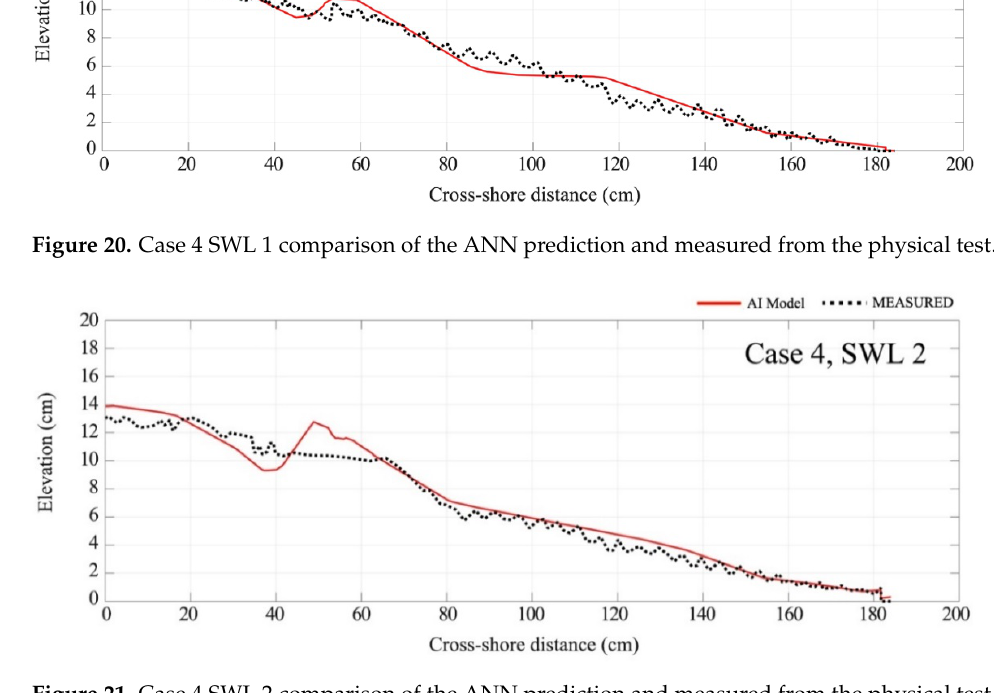
Figure 21. Case 4 SWL 2 comparison of the ANN prediction and measured from the physical test.